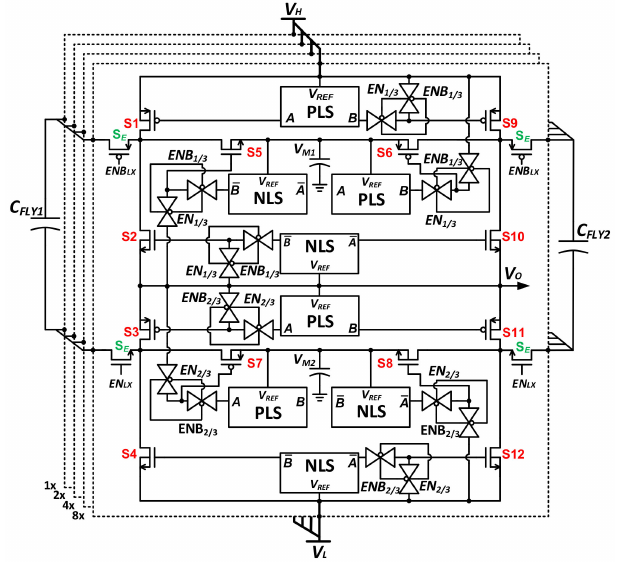
Figure 7. Multi-ratio, multi-leaf SC converter